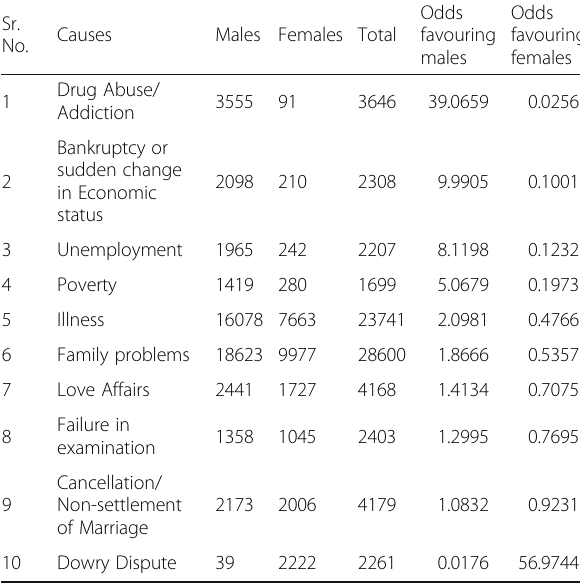
Table 1 Odds ratio for causes of suicides for males and females Sr.